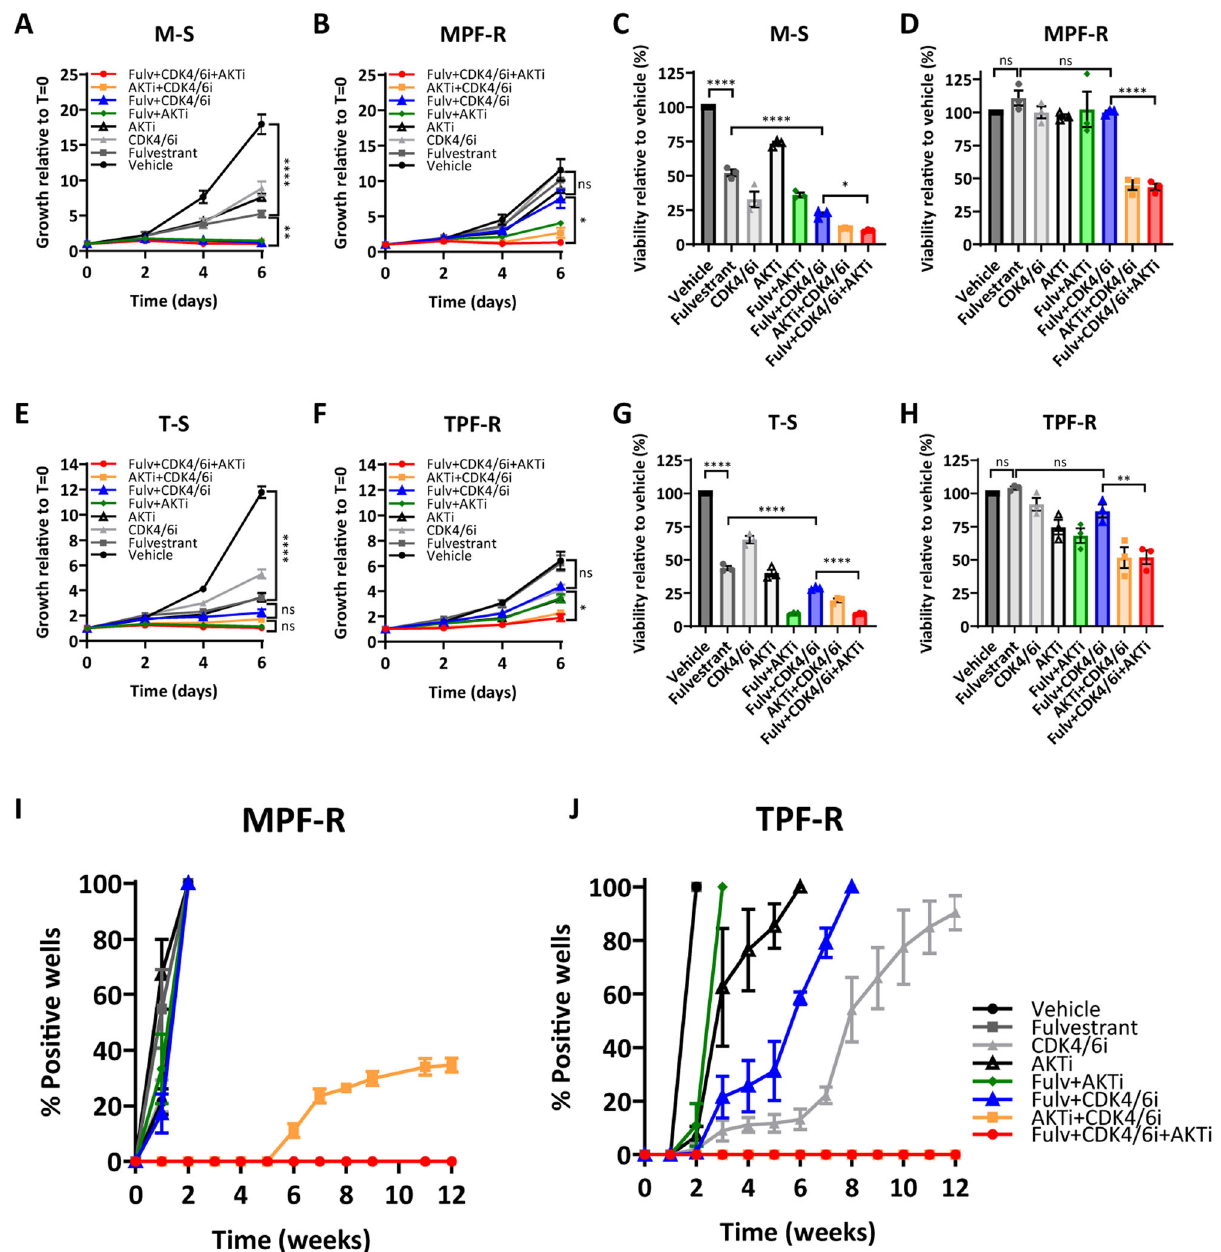
Fig. 4 Combined fulvestrant, CDK4/6i and AKTi is effective in breast cancer cell lines resistant to combined CDK4/6i and fulvestrant. The effect of fulvestrant (Fulv, 100 nM), CDK4/6 inhibitor (CDK4/6i, palbociclib, 200 nM) and AKT inhibitor (AKTi, capivasertib, 250 – 500 nM in the MCF-7 cell model; 100 nM in the T47D cell model), as single agents or in the double and triple combination, was assessed in all cell lines by crystal violet growth assay ( A , B , E , and F ) and CellTiter-Blue viability assay ( C , D , G , and H ) performed over 6 days. Outgrowth of resistant colonies was investigated in MPF-R ( I ) and TPF-R ( J ) cells by weekly evaluation of the percentage of 48 wells at 50% or greater con fl uence (positive wells) over 12 weeks. Experiments were conducted in three biological replicates and data are shown as mean ± SEM. Asterisks indicate signi fi cant differences in one-way ANOVA tests at day 6 (*0.01 < p < 0.05, **0.001 < p < 0.01, ***0.0001 < p < 0.001, and **** p <